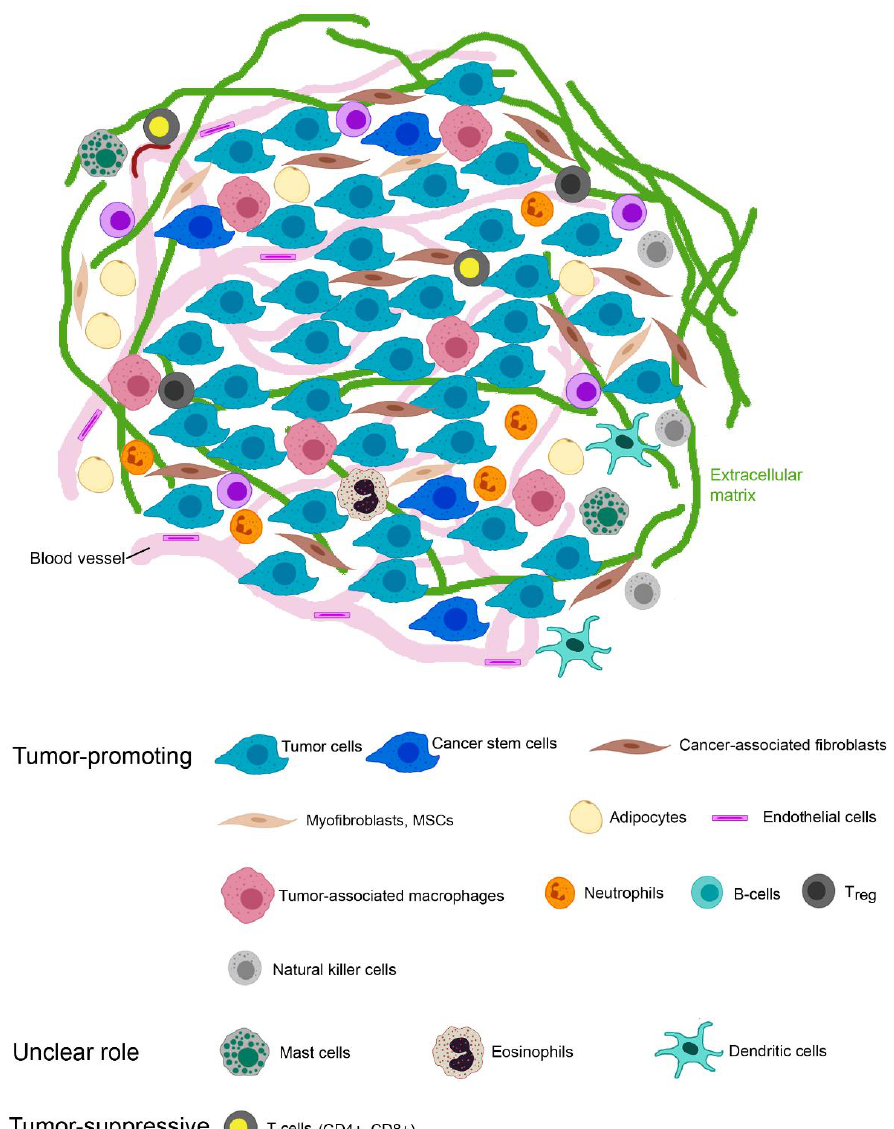
Figure 2. Breast cancer tumors consist not only of tumor cells and cancer stem cells but contain other cells with tumor-promoting functions such as cancer-associated fibroblasts, normal fibroblasts, myofibroblasts, mesenchymal stem cells, tumor-associated adipocytes, endothelial cells and various immune cells (tumor-associated macrophages, neutrophils, natural killer cells and regulatory T-cells). The role of mast cells, eosinophils and dendritic cells in breast cancer is not clear. CD8+ cytotoxic T-cells and CD4+ helper T-cells have anti-tumor action.